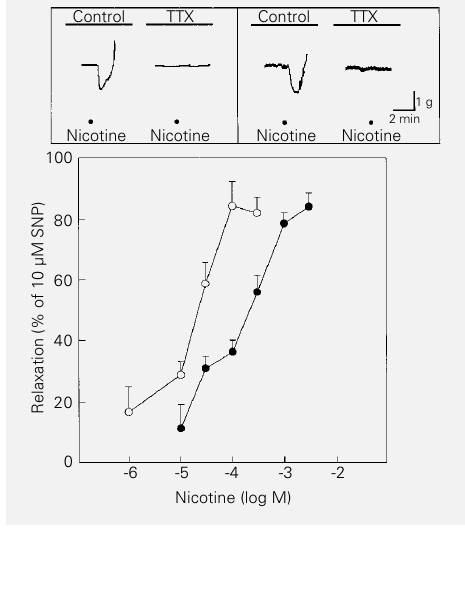
Figure 6 - Top , Representative tracings showing the response elicited by ATP (300 µM) on the isolated lower esophageal sphincter (left) and ileocolonic junction (right) strips in the ab- sence or in the presence of 1 µM tetrodotoxin (TTX). Bottom , Relationship between the mag- nitude of relaxations induced by different concentrations (M) of ATP in isolated lower esoph- ageal sphincter (filled circles) and ileocolonic junction (open circles) strips. Data are reported as the mean ± SEM (N = 6). The relaxation magnitude is reported as % of that obtained with so- dium nitroprusside (SNP). All experiments were performed in the presence of 1 µM atropine and 3 µM